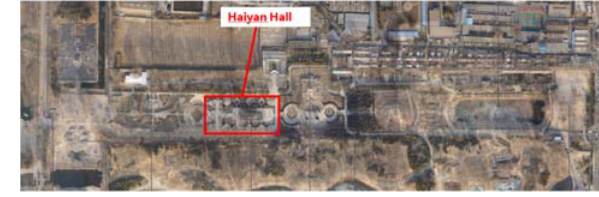
Figure 1.Location Map of Haiyan Hall